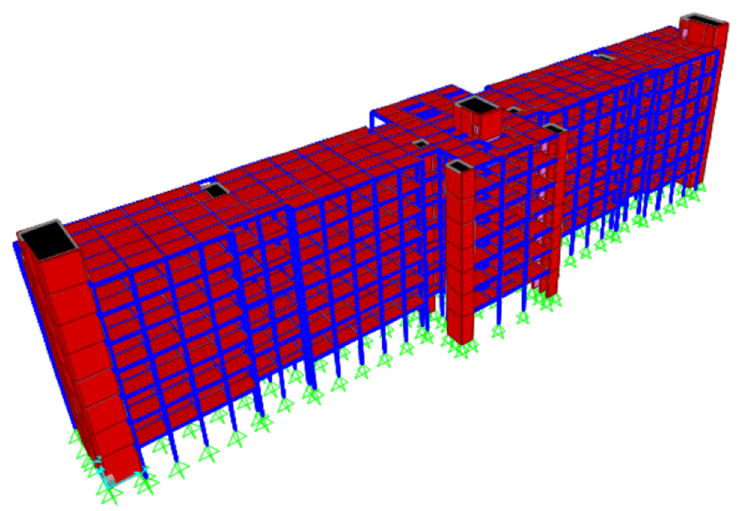
Figure 7. View of FE model developed in SAP2000 [21].